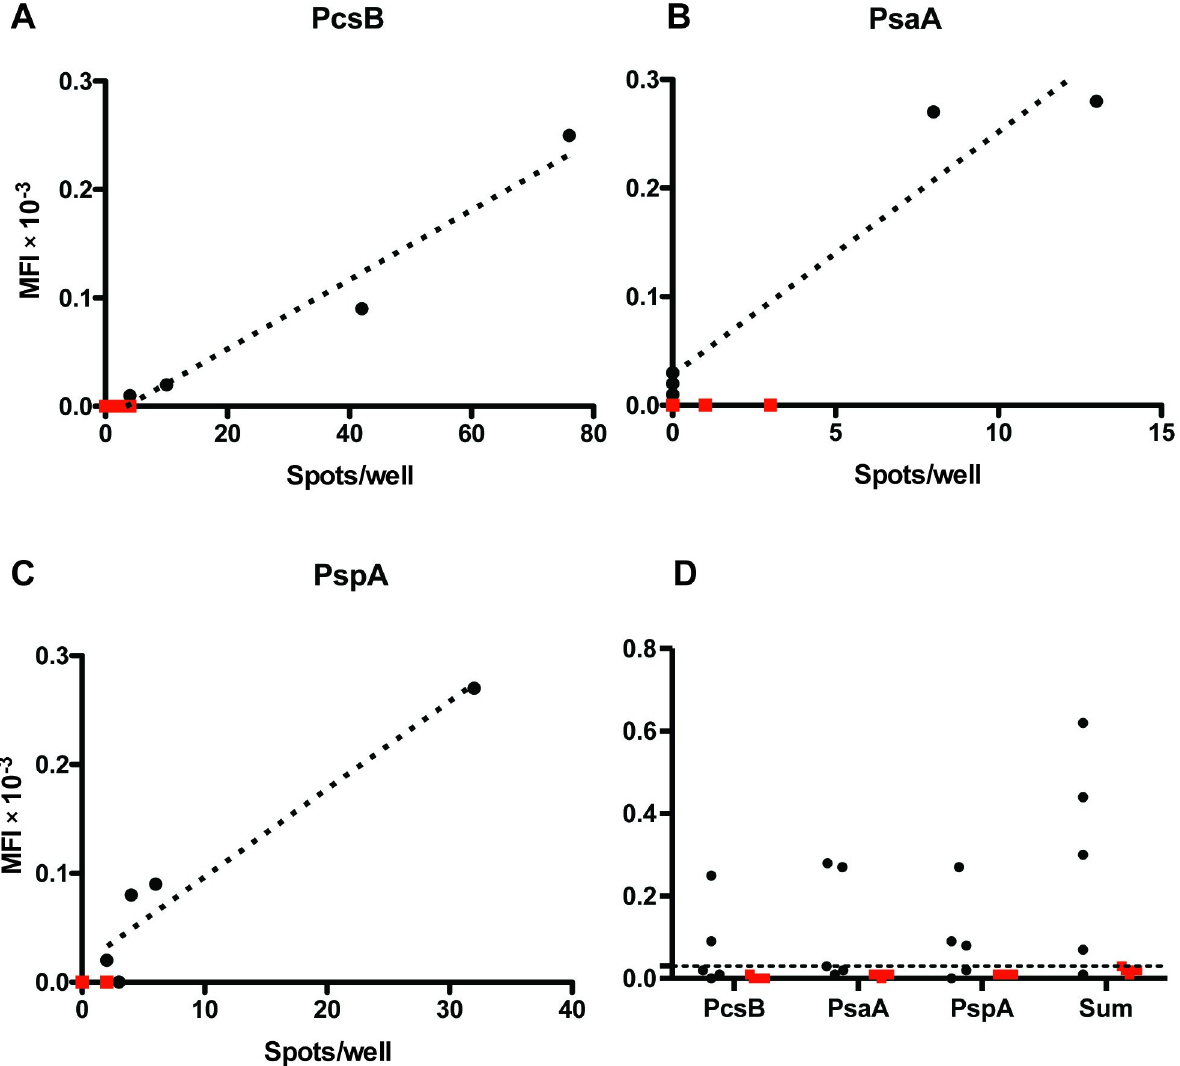
Fig 5. Responses in Medium Enriched with Newly Synthesized Antibodies (MENSA) tests correlate with spots/well in ELISpot immunoassays. Correlation of anti-PcsB (A), anti-PsaA (B), and anti-PspA IgG (C) responses in MENSA by Luminex immunoassay measurements (median fluorescence intensity, MFI × 10 -3 ) and ELISpot counts (spots/well). Black dots represent measured values for the five S . pneumoniae -positive patients; red squares represent the measured values for samples from five S . pneumoniae -negative patients. Summary of MENSA responses measured in each patient for each antigen and for the sum of all antigens (D). The highest value observed for any antigen or their sum among the S . pneumoniae- negative patients is represented as the C 0 for MENSA samples (dashed horizontal line).